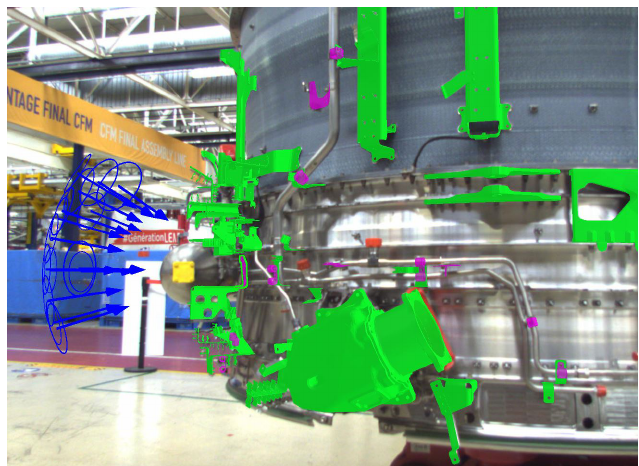
Figure 24. User guidance in the handheld tablet mode (see the blue